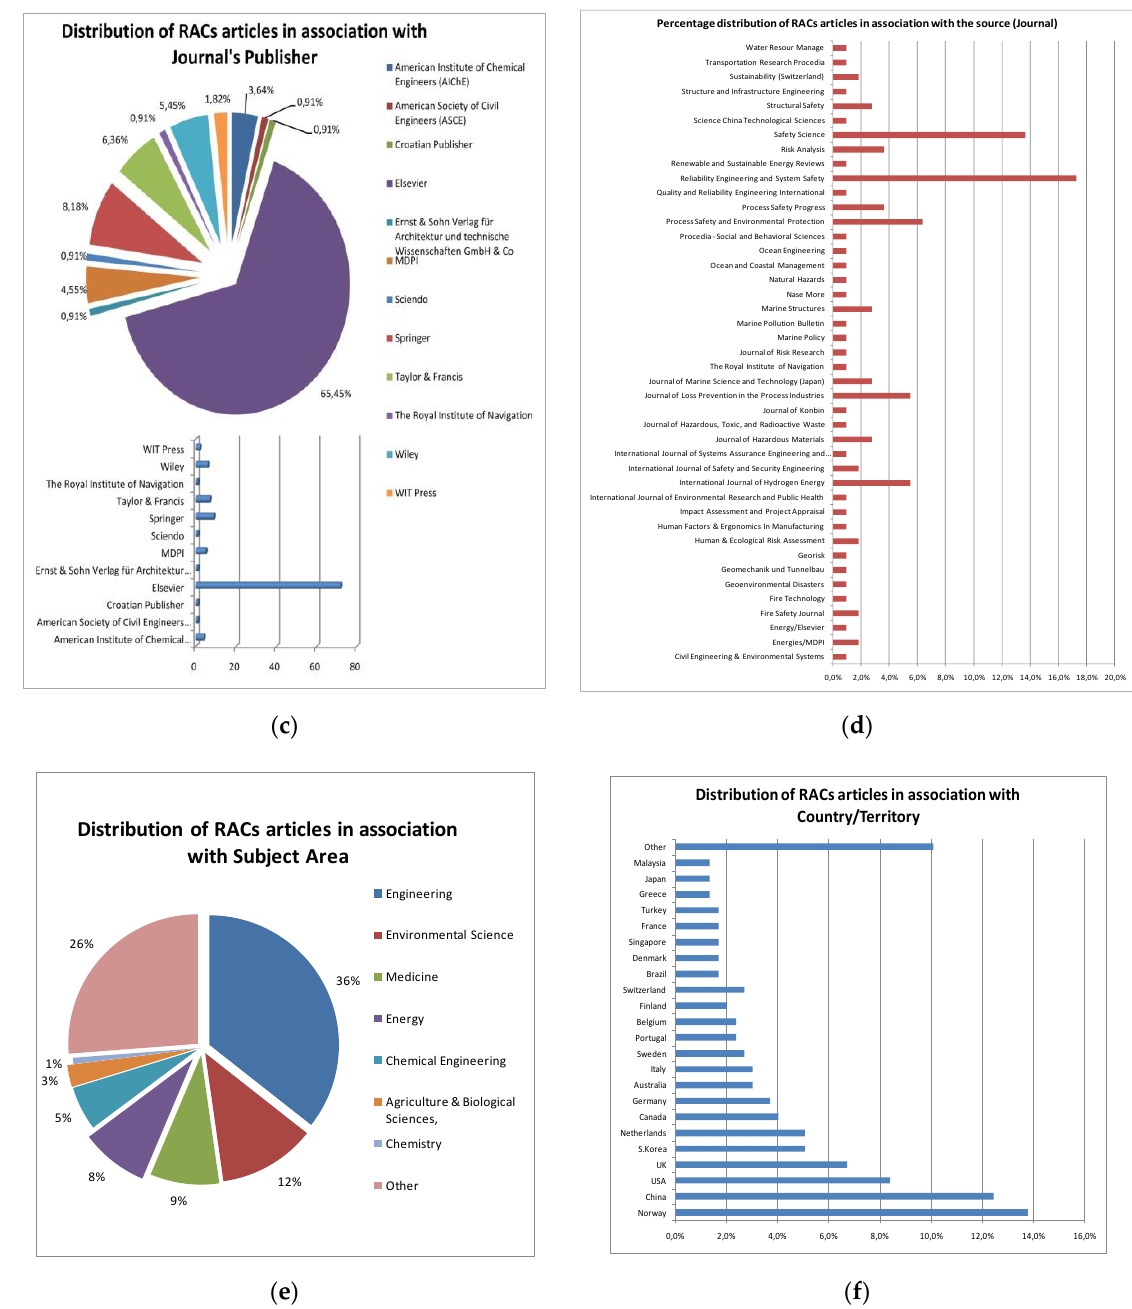
Figure 11. The graphs display the distribution of RAC articles published during the period of January 2000–December 2019 in association with ( a ) OHS and the other subjects, ( b ) journal access type (“open” or “not”), ( c ) journal publisher, ( d ) the source or journal title, ( e ) various OHS subject areas, and ( f ) the country/territory at the international level.